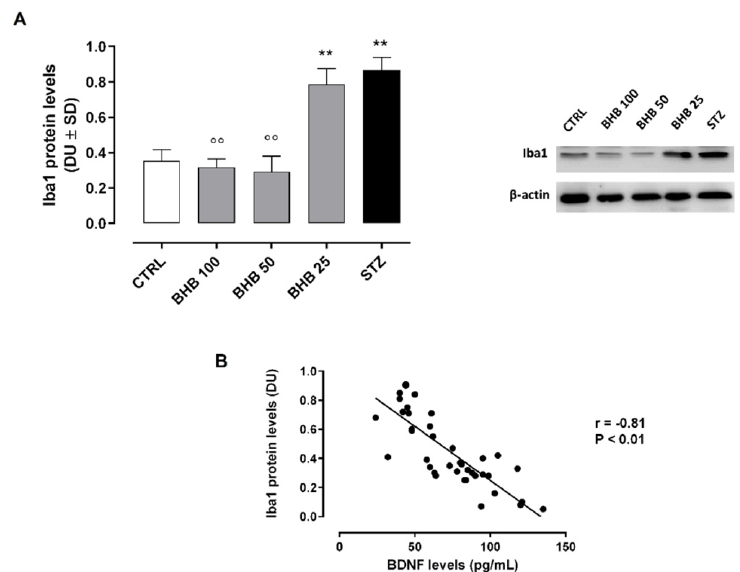
Figure 4. Retinal Iba1 levels ( A ) and their strength of association with BDNF ( B ) in non-diabetic mice (CTRL), diabetic mice (STZ), and diabetic mice treated with BHB 25 mg/kg (BHB 25), 50 mg/kg (BHB 50), and 100 mg/kg (BHB 100). Iba1 levels (densitometric units, DU) are expressed as mean ± SD of N = 8 retinas per group. ** p < 0.01 vs. CTRL; °° p < 0.01 vs. STZ.